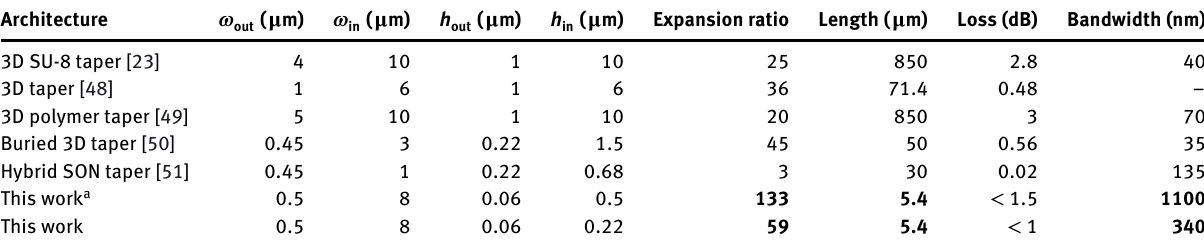
a Simulation result. Bold values indicate the outstanding features in our